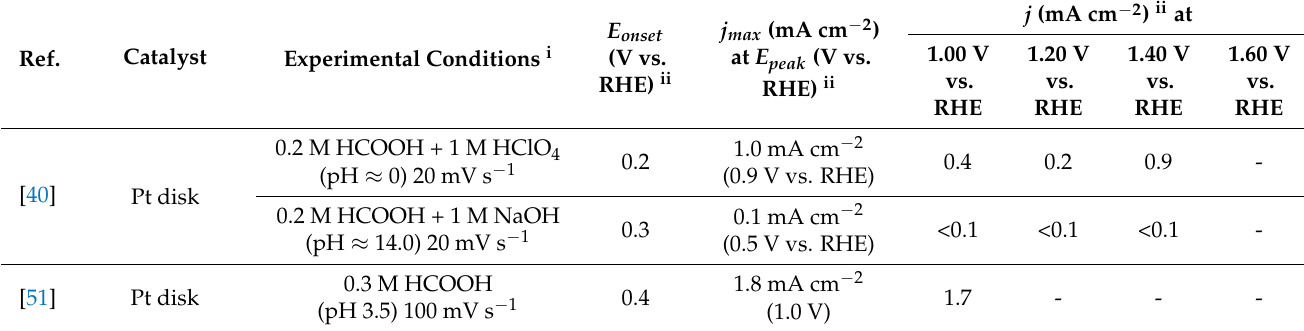
Table 2. Benchmarking of Pt-based electrocatalysts for formic acid/formate oxidation in half-cell configuration at ambient conditions, in acidic and basic media, in terms of onset potential ( E onset ), maximum current density ( j max , normalized by electrode geometric area) obtained on anodic peaks (at a potential E peak ) and current density ( j ) obtained at given potentials.